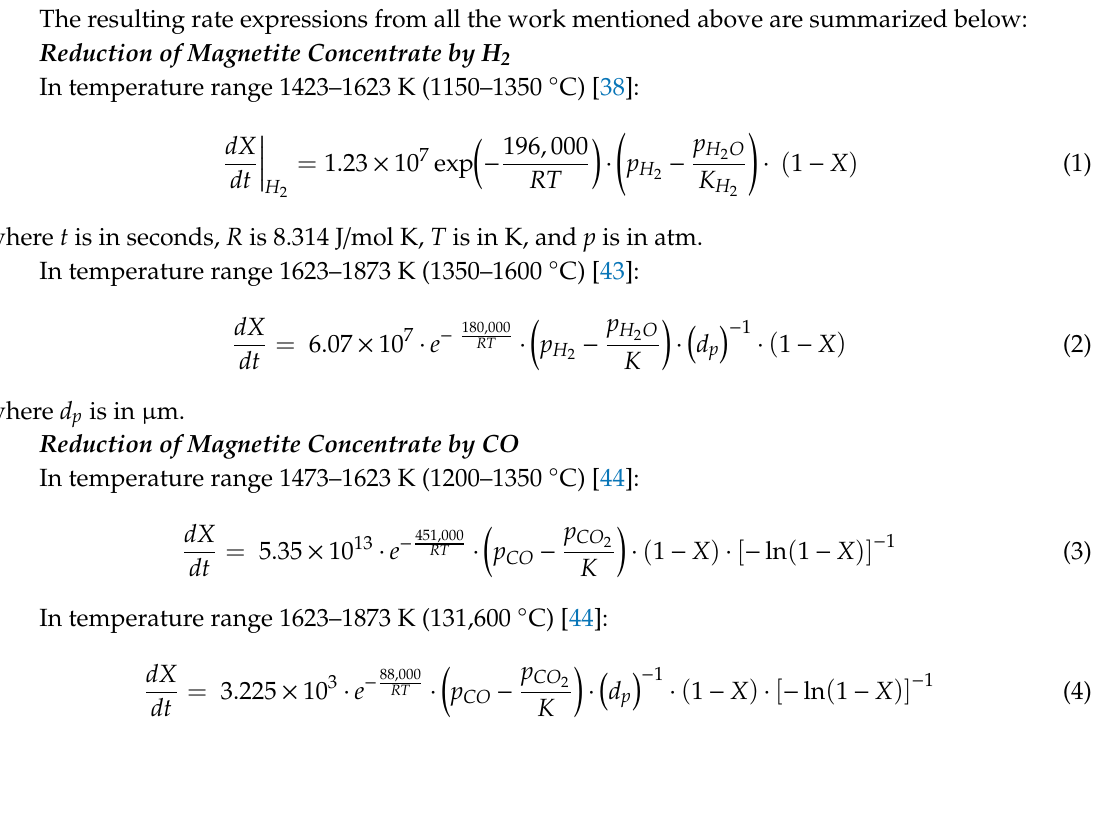
Figure 4. Existence of di ff erent iron oxide phases indicated by: ( a ) SEM micrographs of reduced particles (X = 0.14) and ( b ) XRD of samples at various reduction degrees. (The figure is adapted from [40], with permission from Springer Nature,